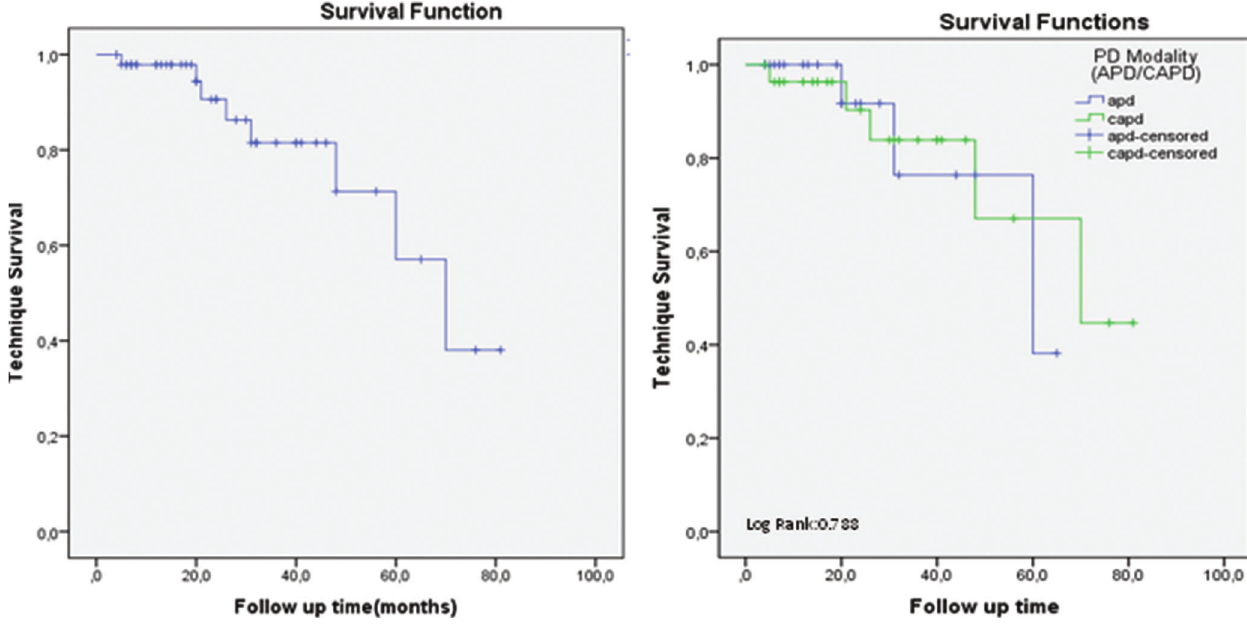
Figure 2 - Technique survival for all patients (2A) and technique survival by PD modality